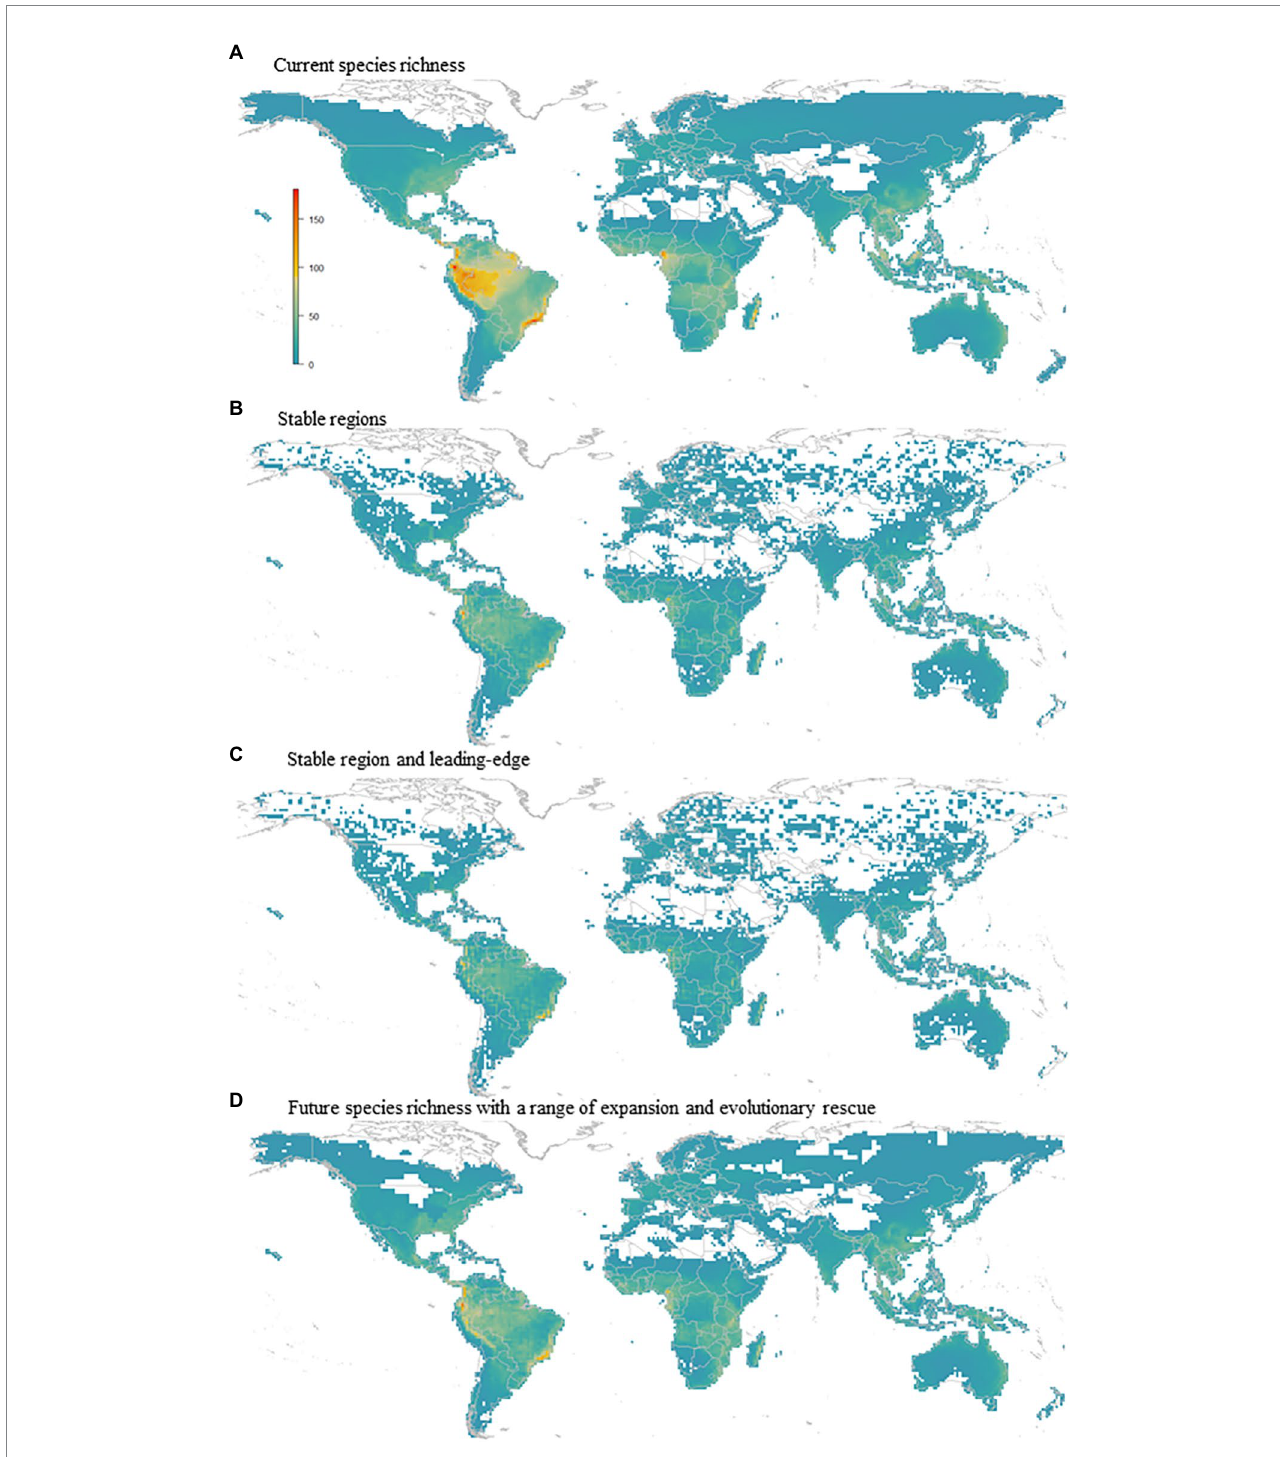
FIGURE 4 Global amphibian diversity pattern (A) Current species richness (max. 181 spp. per pixel); (B) Stable region (max. 118 ssp.); (C) Stable region and leading- edge, max 132; and (D) Future species richness with a range of expansion and evolutionary rescue, max